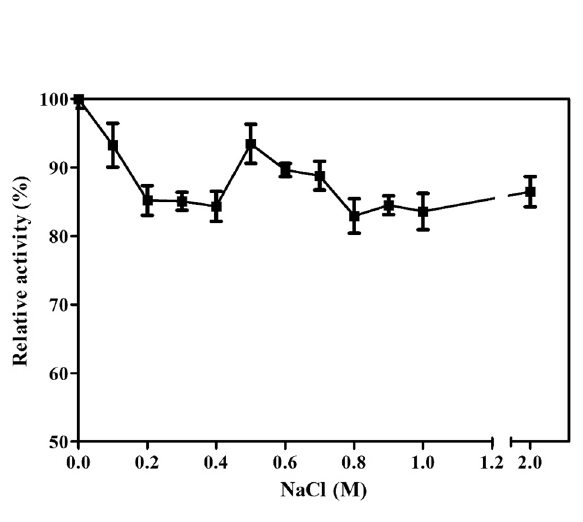
Figure 10. XylR activity in the presence of NaCl in the reaction medium at concentrations of 0.1 to 2 M. Values are represented as the mean percentage ± standard